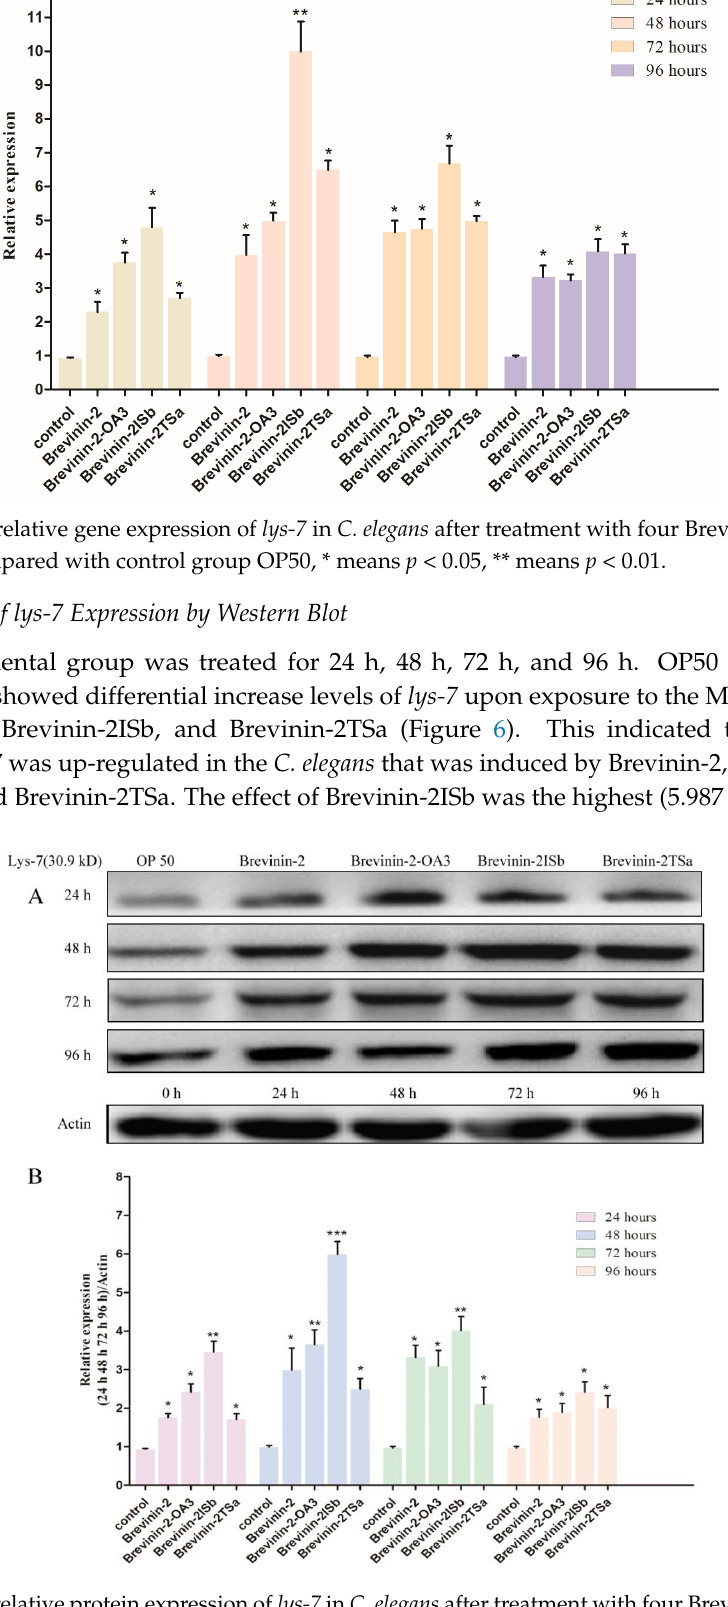
Figure 6. The relative protein expression of lys-7 in C. elegans after treatment with four Brevinin-2 family peptides. Compared with control group OP50, * means p < 0.05, ** means p < 0.01, *** means p < 0.001.